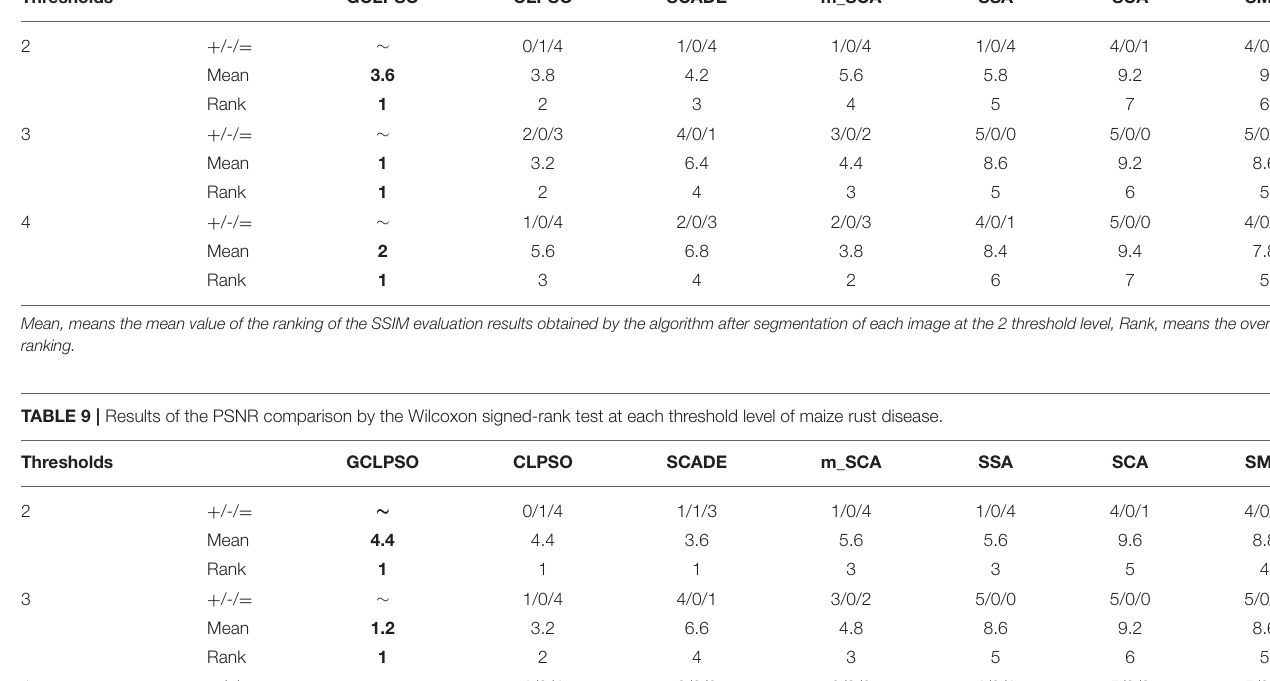
TABLE 8 | Results of the FSIM comparison by the Wilcoxon signed-rank test at each threshold level of maize rust disease. Thresholds